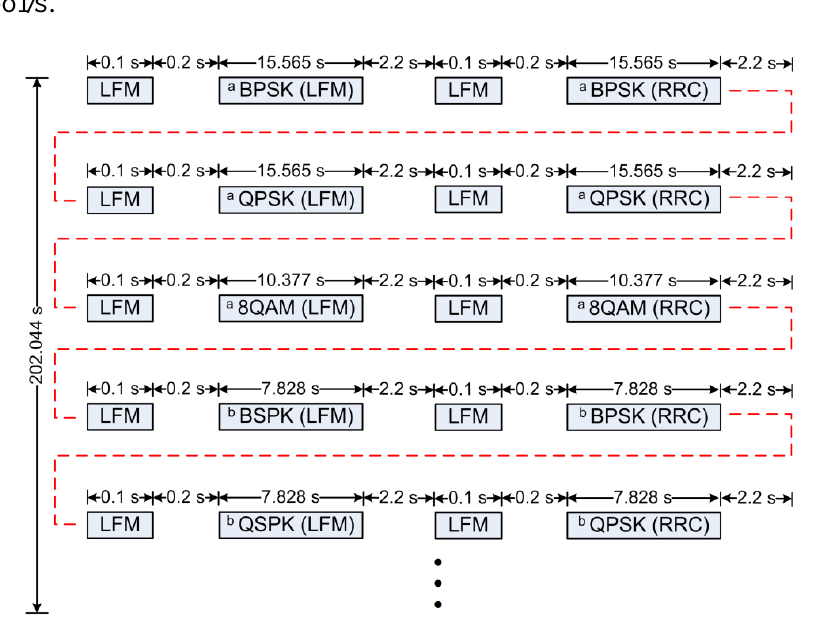
Figure 1. Block diagrams of the transmitted signals using different shaping pulses shown in the parentheses. a The symbol rate was 1 kilo-symbol/s; b The symbols rate was 2 kilo-symbol/s.